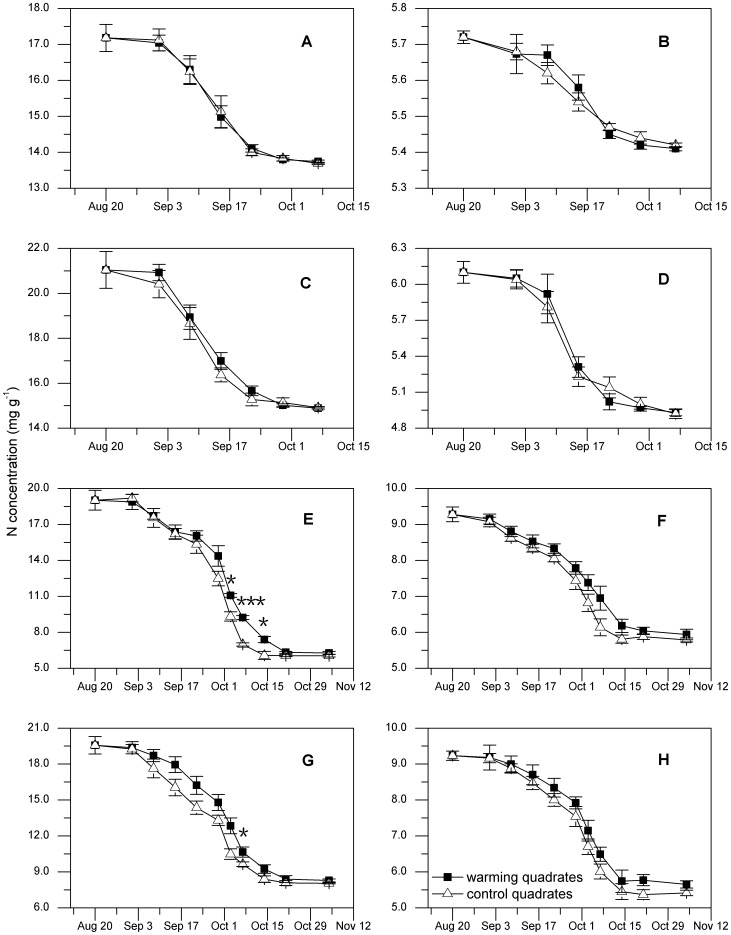
Effects of warming on N concentration during the plant senescence.N loss in leaves (the left column) and culms (the right column) for E. regelii (A, B), S. mussotii (C, D), D. caeruleum (E, F) and E. nutans (G, H) during the plant senescence in autumn, 2011. Error bars are SE (n = 3). Asterisks indicate significant differences for each collection in warming and control quadrates: *** indicate P<0.001; * indicates P<0.05.